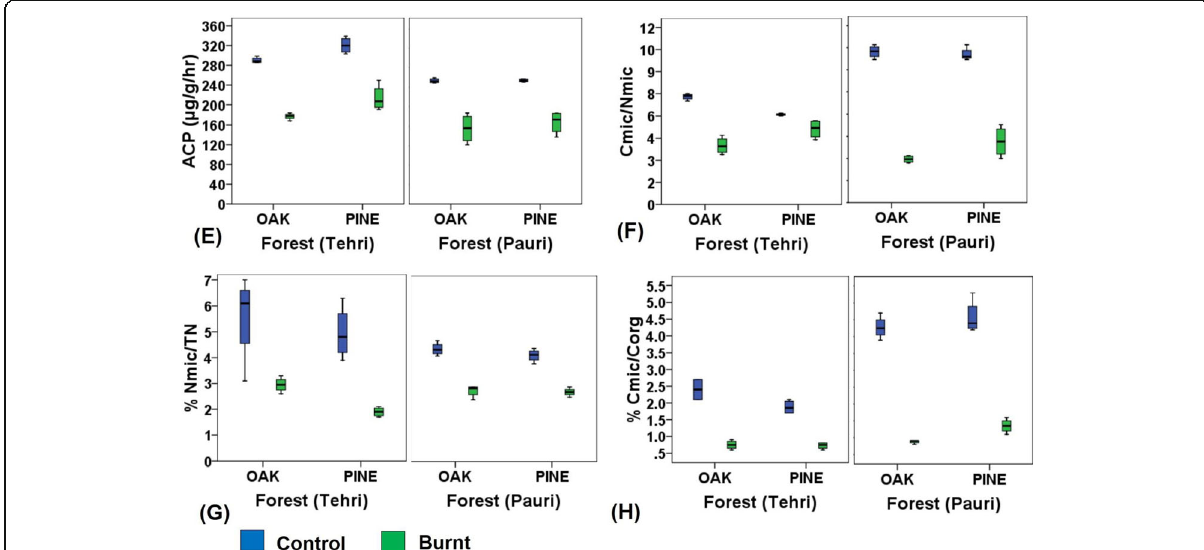
Fig. 3 e and f – h represent mean values of acid phosphatase activity (ACP) and soil microbial indices (C mic /N mic , %N mic /TN, %C mic /C org ) respectively at the control and burnt site in two different forests ( C mic , soil microbial biomass carbon; N mic , soil microbial biomass nitrogen; C org , organic carbon; TN , total nitrogen)